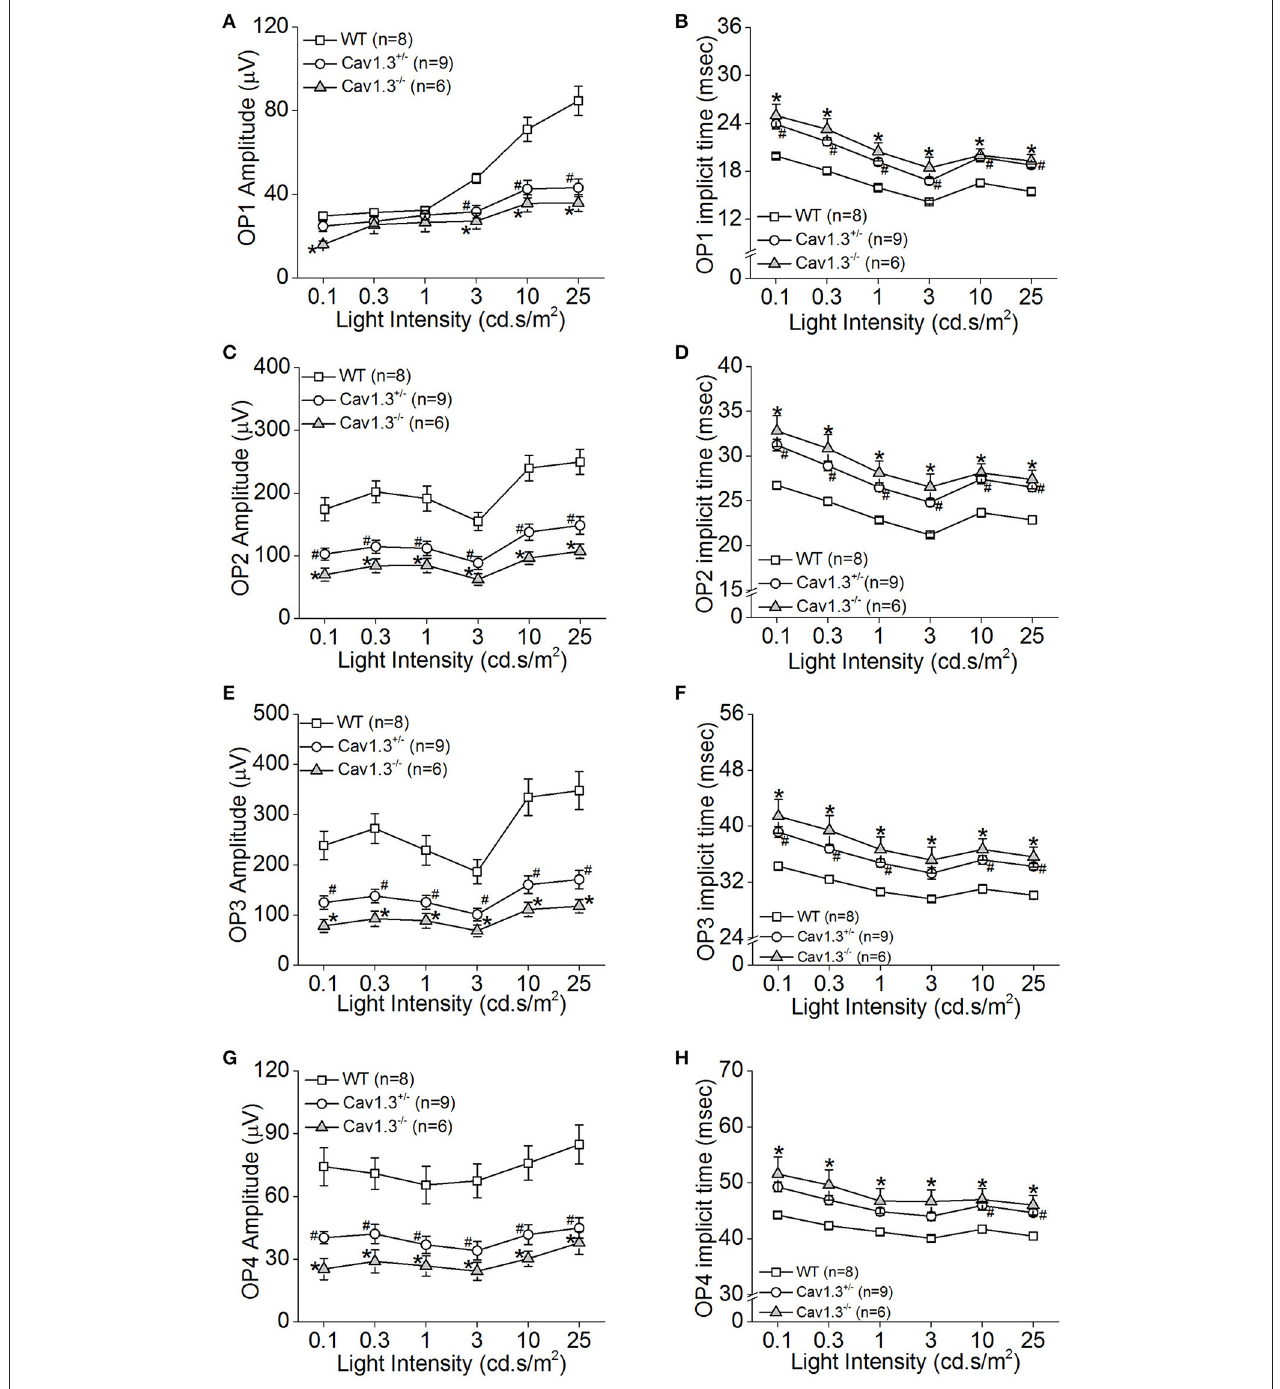
FIGURE 5 | The inner retinal light responses are decreased in Ca v 1.3 + / − and Ca v 1.3 − / − mutant mice. The oscillatory potential (OP) amplitudes are decreased and implicit times delayed in both Ca v 1.3 + / − and Ca v 1.3 − / − mice compared to the wild type (WT). The OPs were analyzed after the scotopic ERG responses were filtered between 100 and 300Hz band-pass using the ERGView4.4 software (Ocuscience). (A,B) The average OP1 amplitudes (A) are decreased, but the implicit time (B) is increased in Ca v 1.3 + / − and Ca v 1.3 − / − mice compared to the WT. (C,D) The average OP2 amplitudes (C) are decreased, but the implicit time (D) is increased in Ca v 1.3 + / − and Ca v 1.3 − / − mice compared to the WT. (E,F) The average OP3 amplitudes (E) are decreased, but the implicit time (F) is increased in Ca v 1.3 + / − and Ca v 1.3 − / − mice compared to the WT. (G,H) The average OP4 amplitudes (G) are decreased, but the implicit time (H) is increased in Ca v 1.3 + / − and Ca v 1.3 − / − mice compared to the WT. The asterisk (*) indicates a statistically significant difference between the WT and Ca v 1.3 − / − mice; “#” indicates a statistically significant difference between the WT and Ca v 1.3 + / − mice. * , # p <